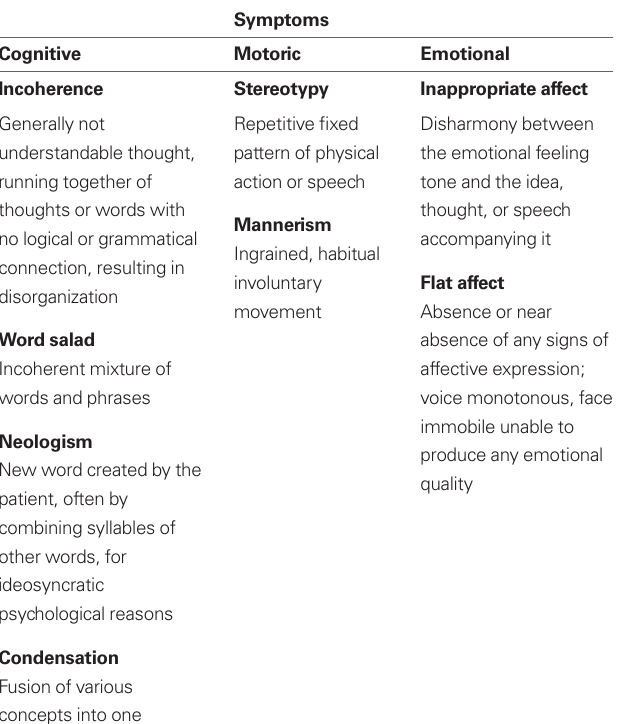
Table 3 | Schizophrenic symptoms possibly caused by incoherence in the oligodendrocyte–axonic system.